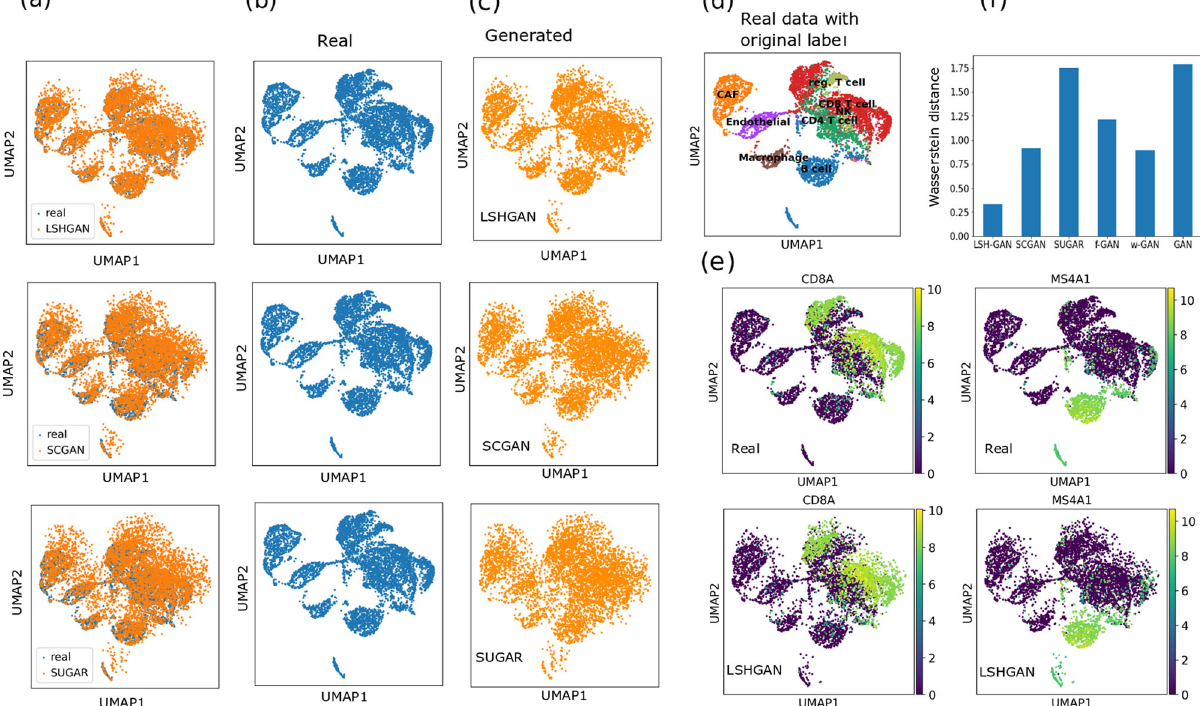
Fig. 3 Comparisons of LSH-GAN with the state-of-the-arts on the melanoma data. a – c UMAP visualization of real and generated cell samples of melanoma data. d UMAP visualization of real scRNA-seq data with the original labels. e Expression values (shown in color bar) of two marker genes CD 8 A (marker of CD8 T cell) and MS 4 A 1 (marker of B cell) in real and generated data. f Barplot describing the Wasserstein distance between the generated and real cell